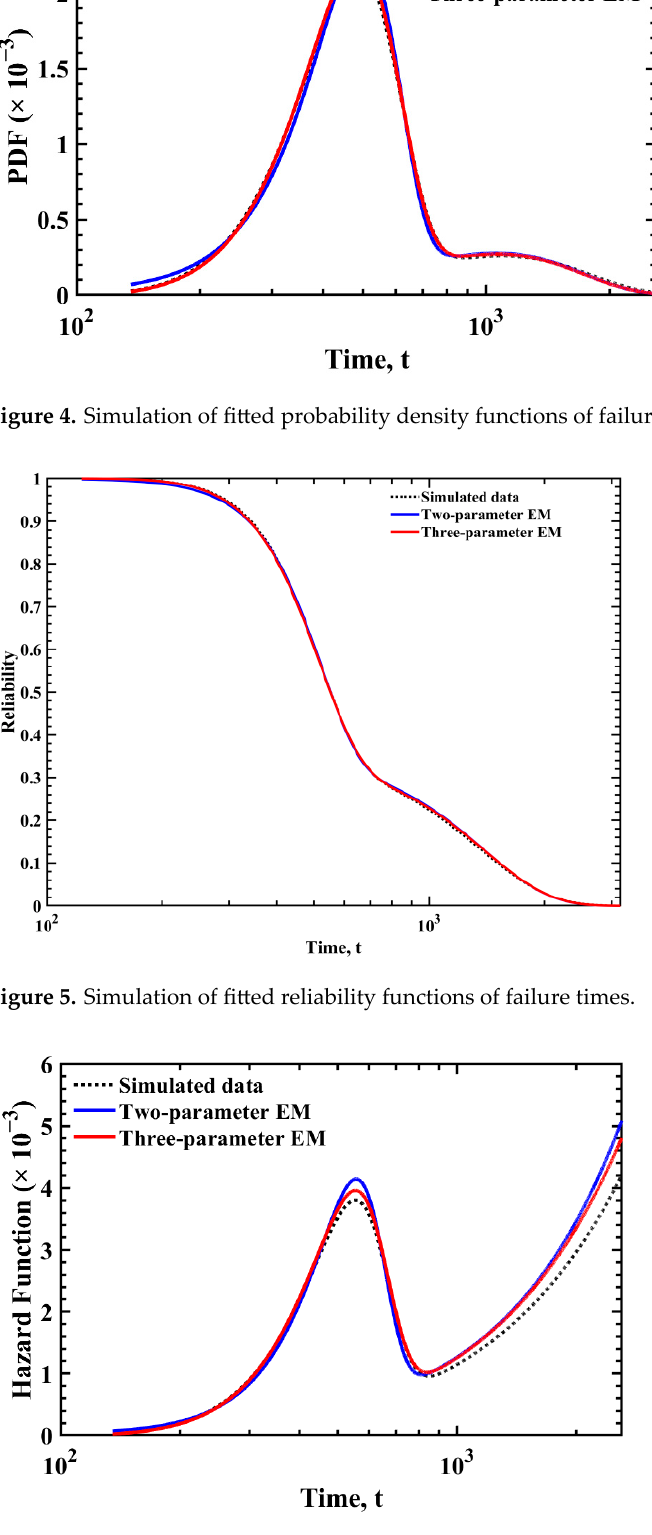
Figure 6. Simulation of fitted hazard functions of failure times.